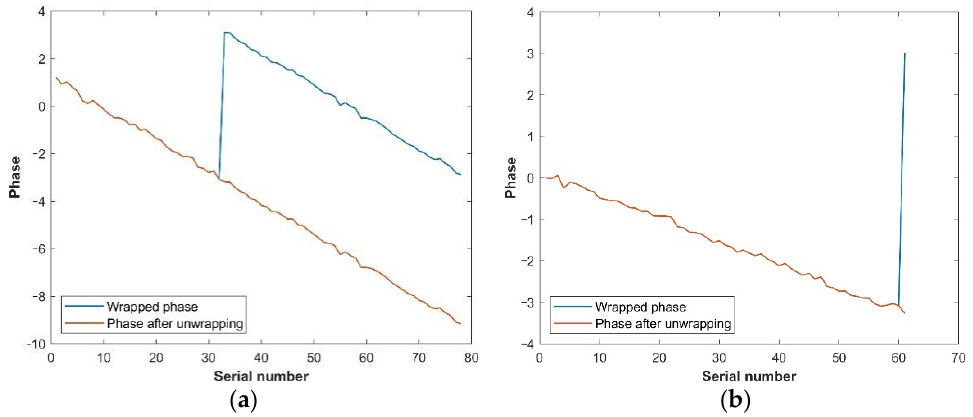
Figure 5. Left and right singular vector phase unwrapping, where ( a ) is the winding phase and unwrapping phase of u 1 , and ( b ) is the winding phase and unwrapping phase of v 1 .